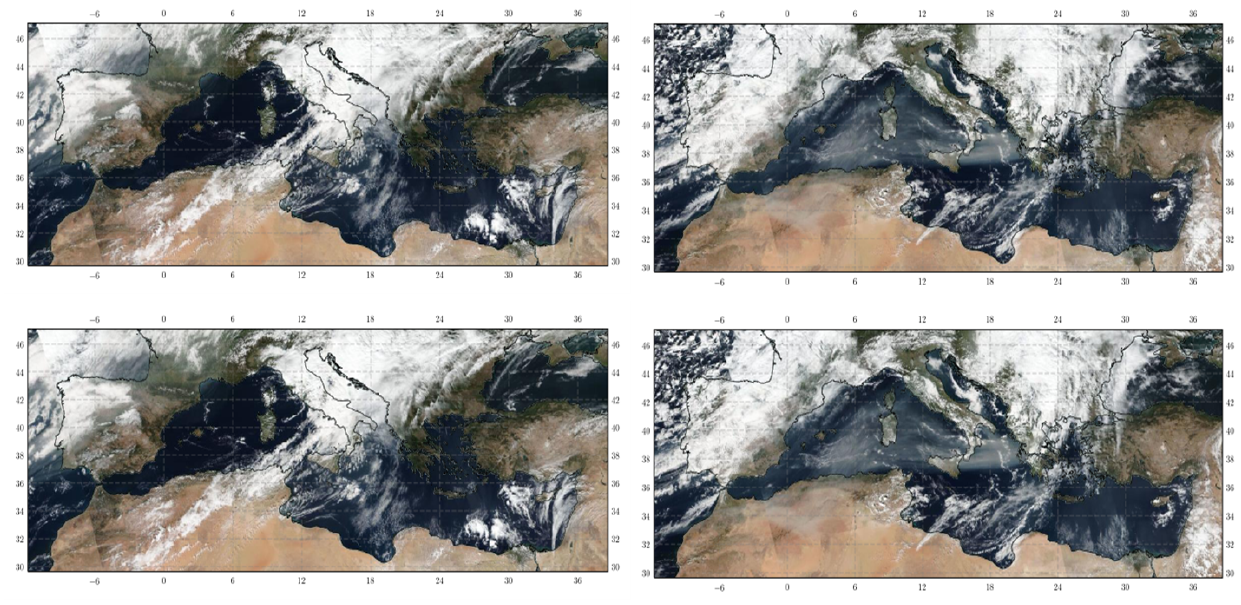
Figure 6. VIIRS/Suomi NPP true-colour images for the four smoke scenes on 24–27 October 2020 (maps are generated from NASA Worldview Snapshots: https://wvs.earthdata.nasa.gov/, last access: 2 June 2022).